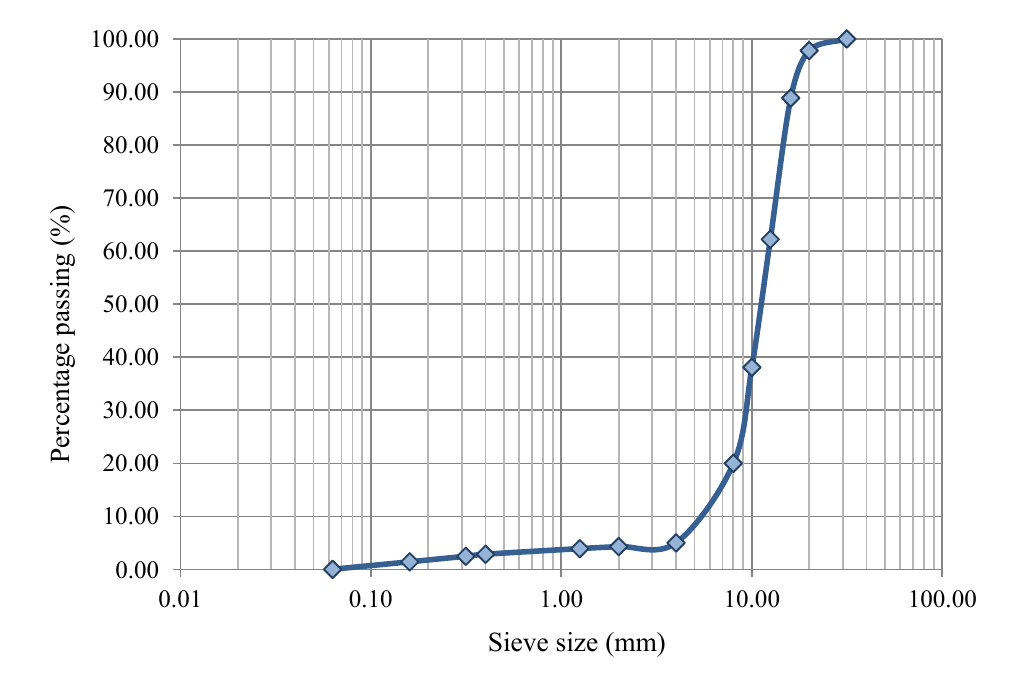
Figure 1. Granulometric curves of the